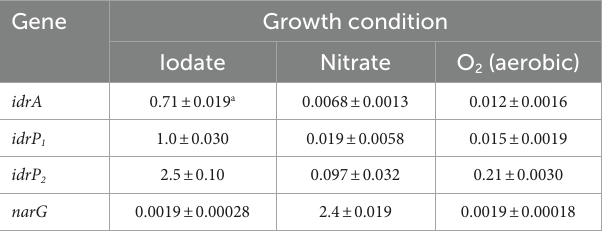
TABLE 1 Expression of idr genes and narG gene relative to that of recA gene in iodate-, nitrate-, or aerobically grown cells. Gene